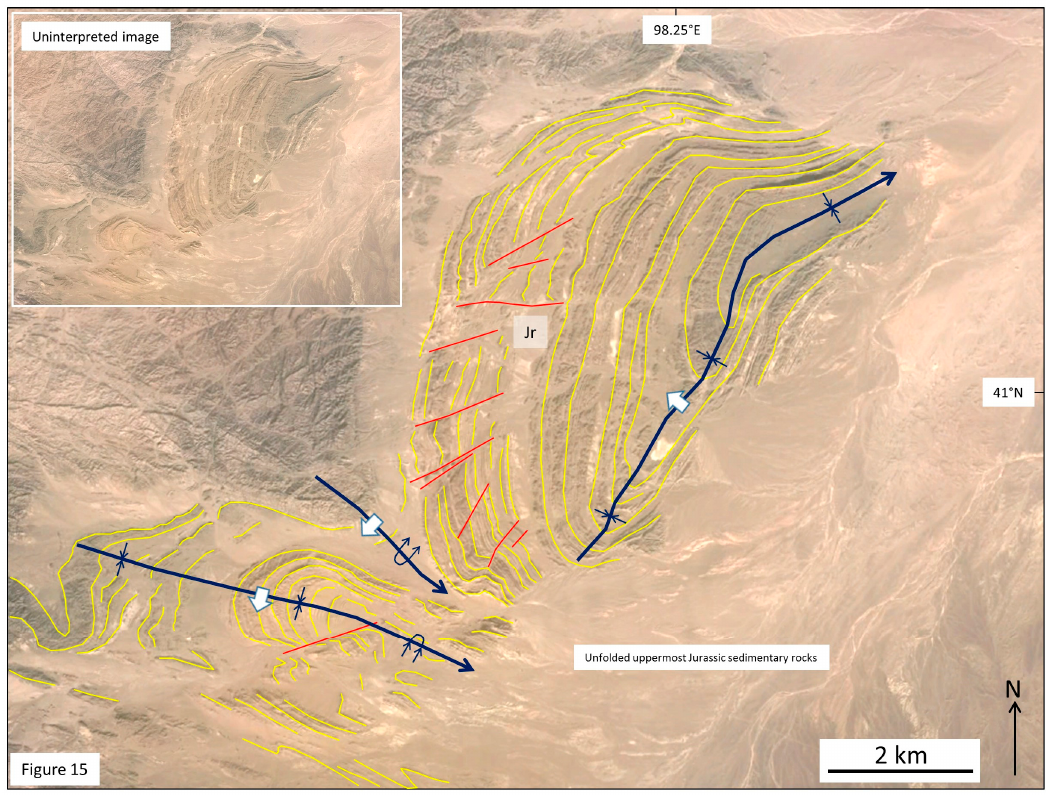
Figure 15. Google Earth (© 2016 DigitalGlobe) image interpretation showing bedding traces (yellow lines) and major fold hinges in folded Jurassic succession (Jr), eastern Beishan, China. Thick white arrows indicate direction of fold vergence. See Figure 1 for location.